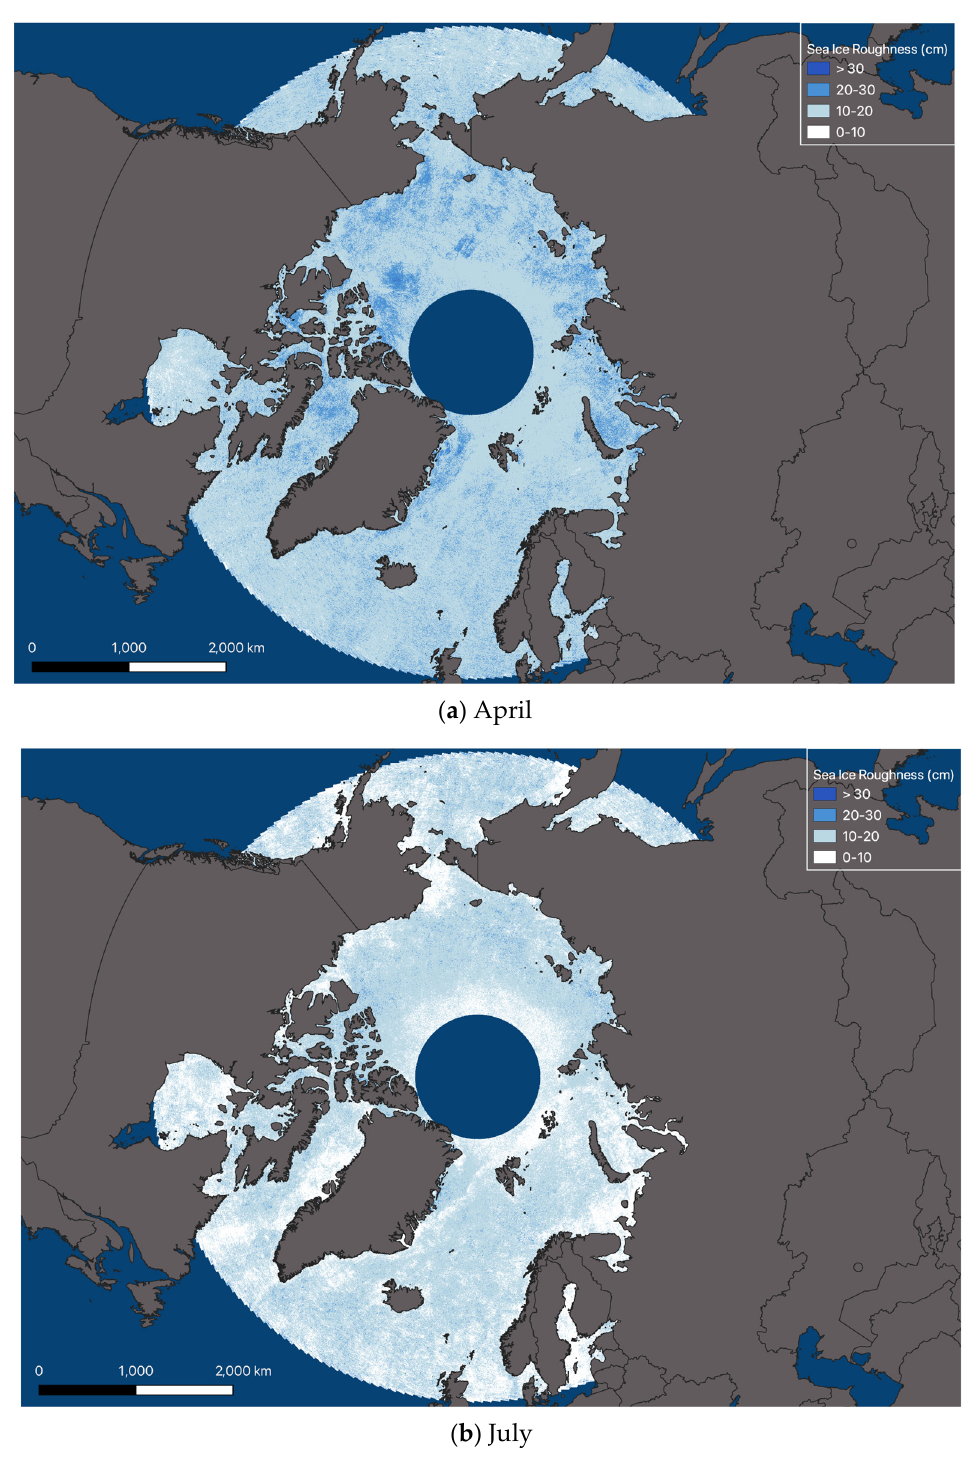
Figure 4. Spatial patterns of mean sea ice surface roughness derived from MISR images (275 m resolution) over the Arctic region for 16-day periods of ( a ) 15–30 April 2016 and ( b ) 10–25 July 2016. Maps in Figure 4 visualize the spatial patterns in sea ice roughness over the Arctic.